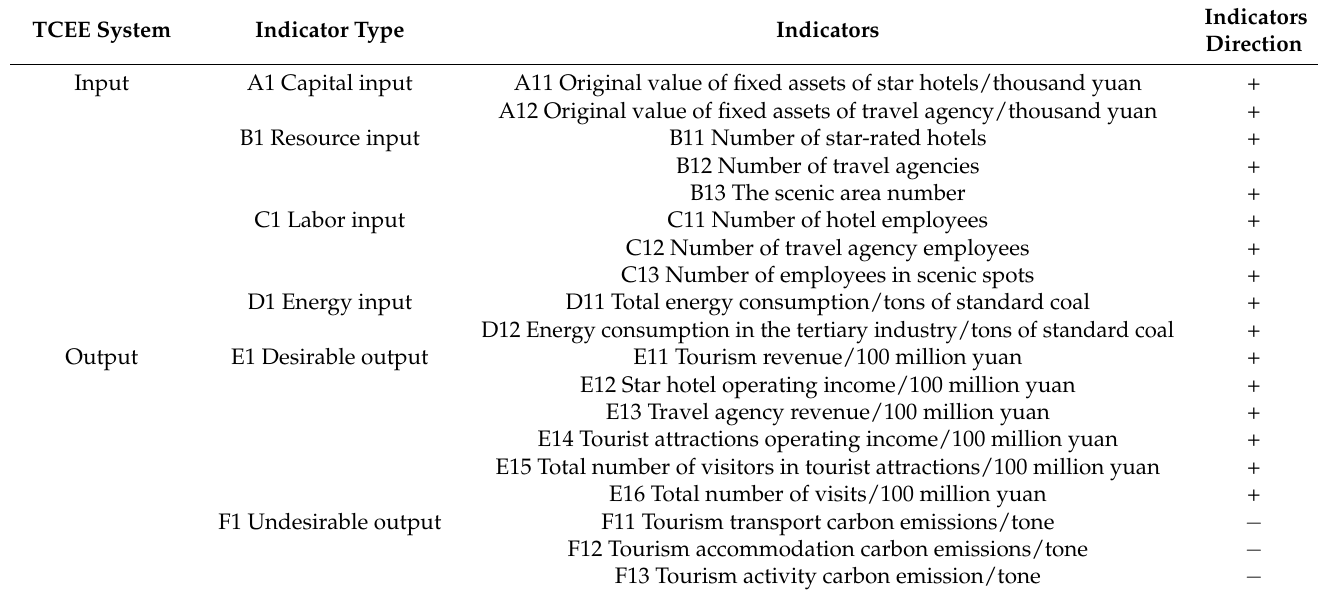
Table 1. Evaluation index system of tourism’s carbon emission efficiency